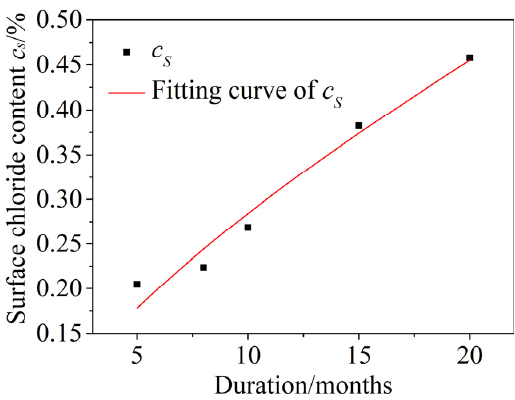
Figure 11. Time-dependent surface chloride content c s .